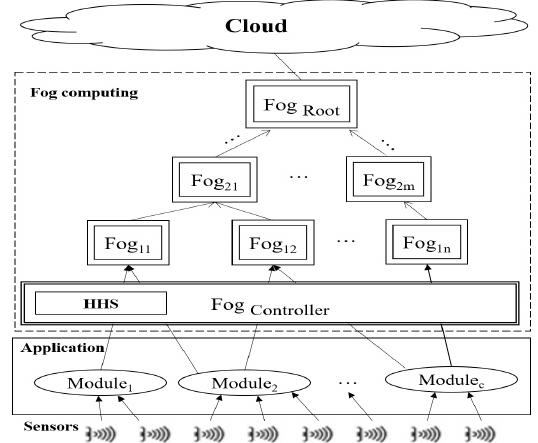
Figure 1. Allocation of PEs to modules in FDs.